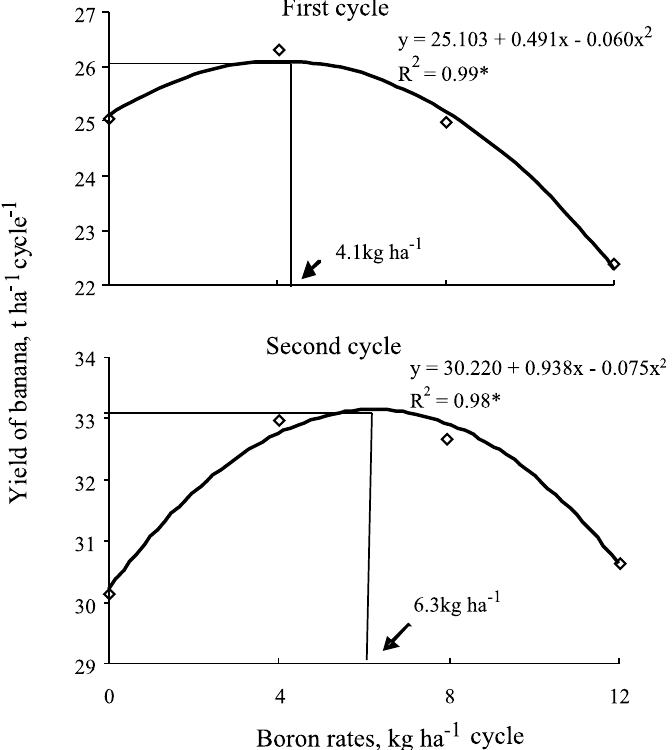
Fig. 1 – Yield of banana (t ha − 1 cycle − 1 ) in the first and second cycles in response of B rates. *Significant at 5% (first cycle) and 10% (second cycle) level of probability –